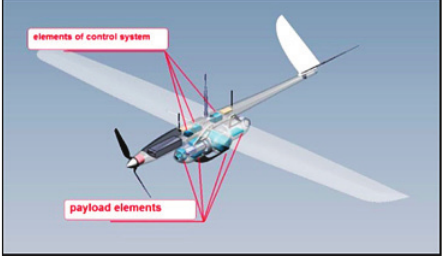
Fig. 2. Design layout of UAV (Urbahs et al . 2008)